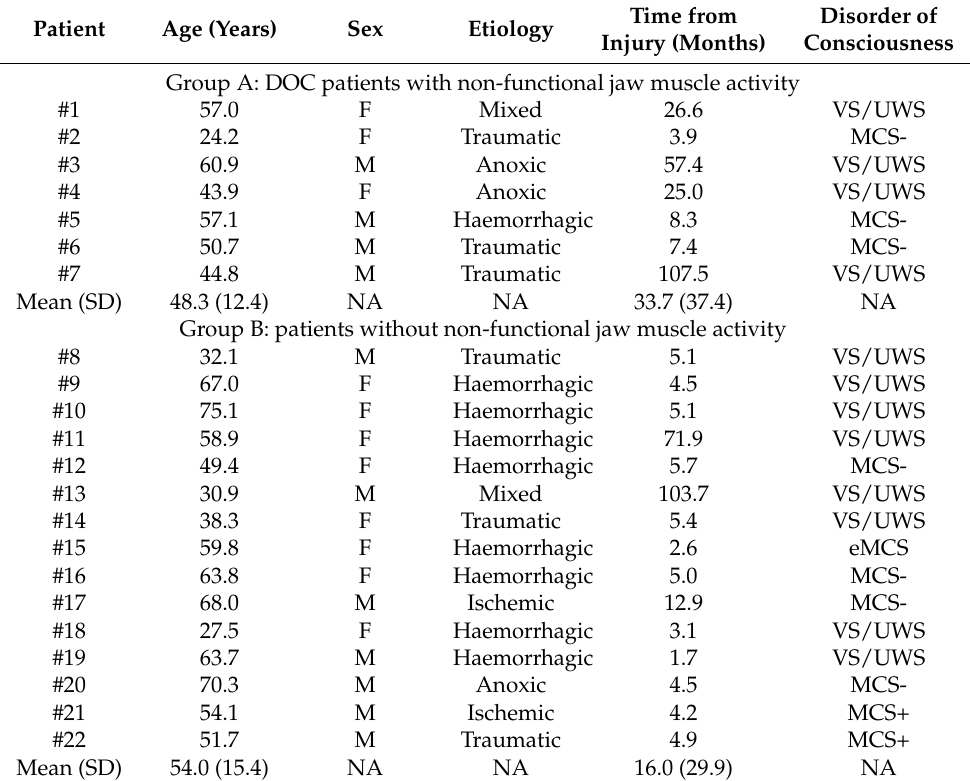
Table 1. Demographic and clinical data of the